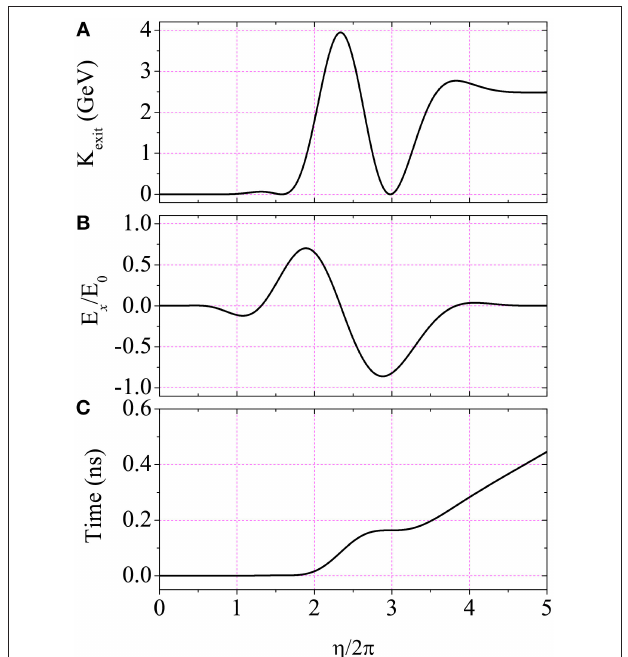
FIGURE 3 | (Color online) (A) Evolution of the electron kinetic energy with η during interaction with a 10 20 W/cm 2 chirped pulse ( b = − 0.038) of wavelength λ = 1 µ m, ϕ 0 = 0, and containing 5 cycles in η . (B) The normalized electric field seen by the electron during interaction with the pulse. (C) The transcendental relation connecting the laboratory time t with η . The electron is injected axially with kinetic energy K 0 ∼ 2 MeV ( γ 0 = 5). Front of the pulse is assumed to have caught up with the electron at t = 0, at the origin of coordinates.